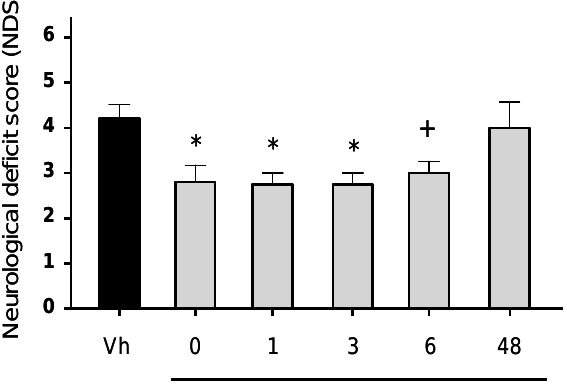
Figure 4. Neurodeficit score outcomes after cerebral ischemia in the therapeutic window study of ISQ-201. The bar graph shows the neurological deficit score (NDS) in ischemic animals at 5 days of reperfusion after ischemia. Animals were treated with the vehicle (Vh) or ISQ-201 (0.05 mg / kg), by an intravenous injection at the onset of reperfusion, or at 1, 3, 6, or 48 h of reperfusion after global cerebral ischemia. The values represent the mean of 6 − 7 independent animals, and the error bars indicate the SE, * p < 0.05 or + p < 0.05, compared with the vehicle by Dunn’s or Mann–Whitney post-test, respectively, after the Kruskal−Wallis test.